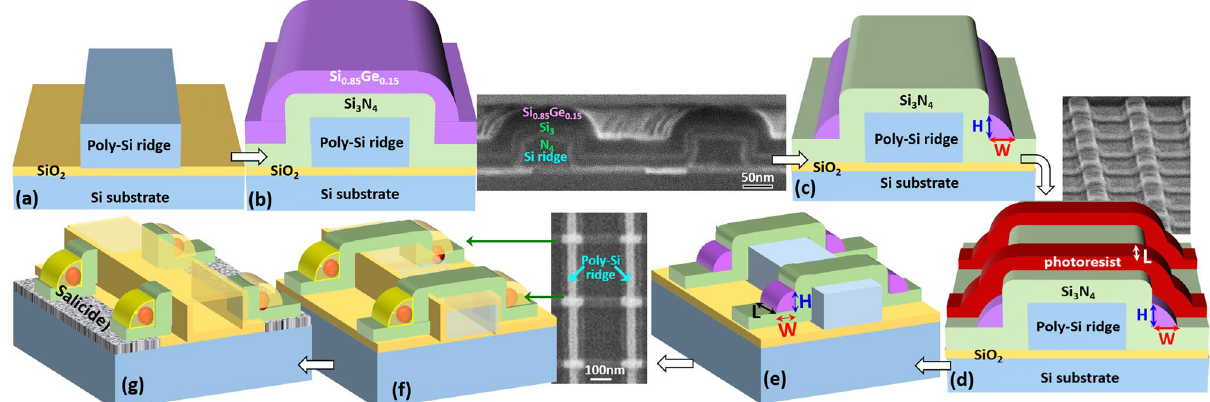
Figure 1. Detailed process flow diagrams showing the fabrication of double QDs embedded within SiO 2 /Si 3 N 4 matrices via the thermal oxidation of nano-patterned SiGe spacer layers encapsulating Si 3 N 4 layers that are deposited over ridges of poly-Si. ( a ) Lithographically-patterned, 20–75 nm-wide poly-Si ridges are formed over buffer layers of SiO